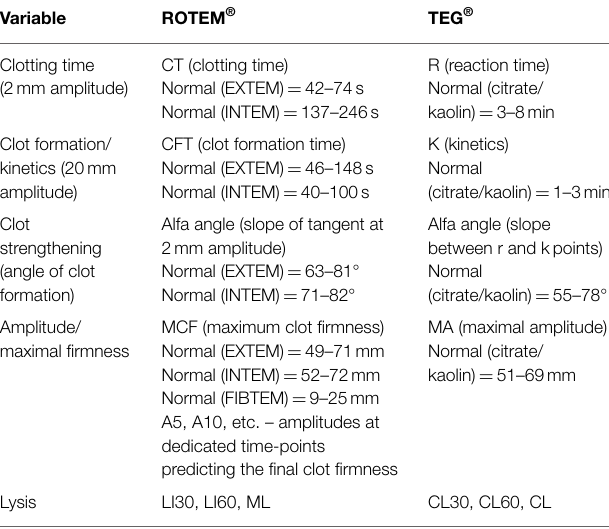
TABLE 2 | List and comparison of the most important variables describing the VEM-derived curve .